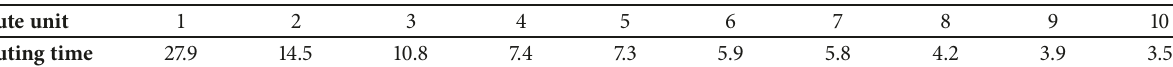
Table 6: Calculating time with different number of compute